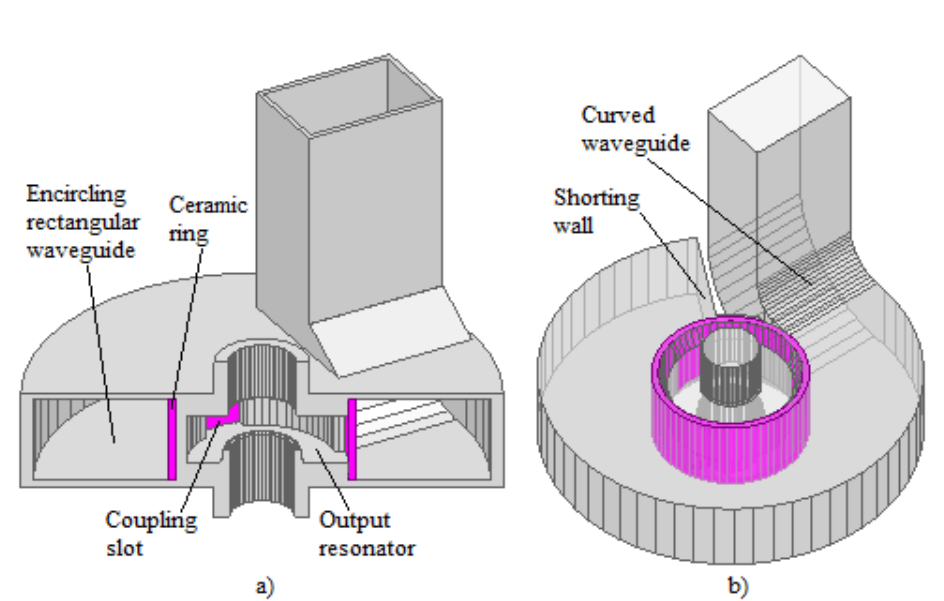
Fig. 1. High-power klystron output window integrated with the output resonator. a) – device appearance (sliced), b) – vacuum